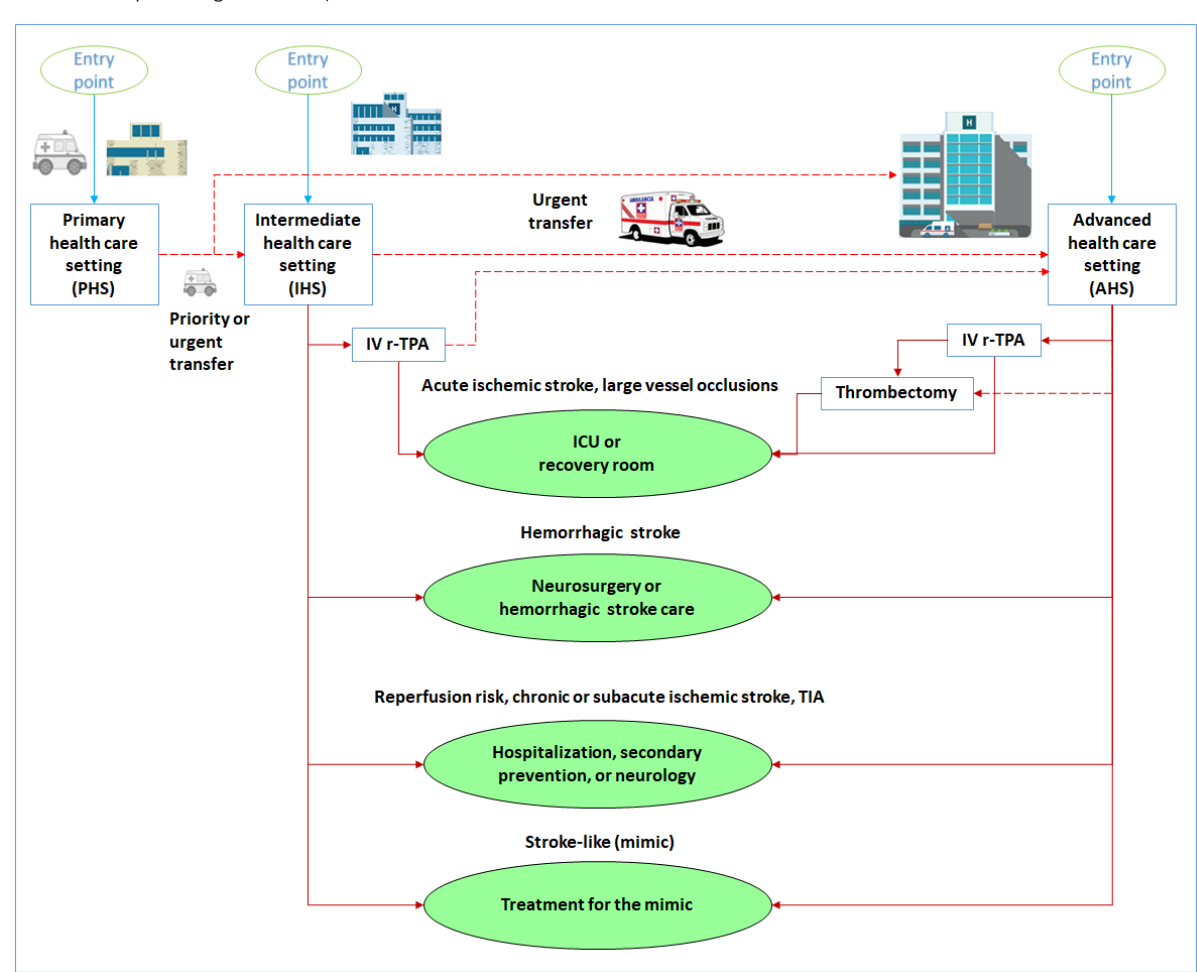
Figure 1. Interaction between the three health care settings and final possible diagnosis and referrals. ICU: intensive care unit; IV rtPA: intravenous recombinant tissue plasminogen activator; TIA: transient ischemic